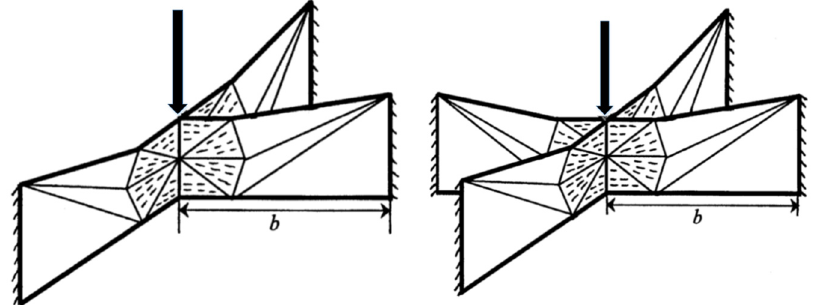
Figure 18. The schematic diagram of the T-shaped frame ( left ) and cross frame ( right ).